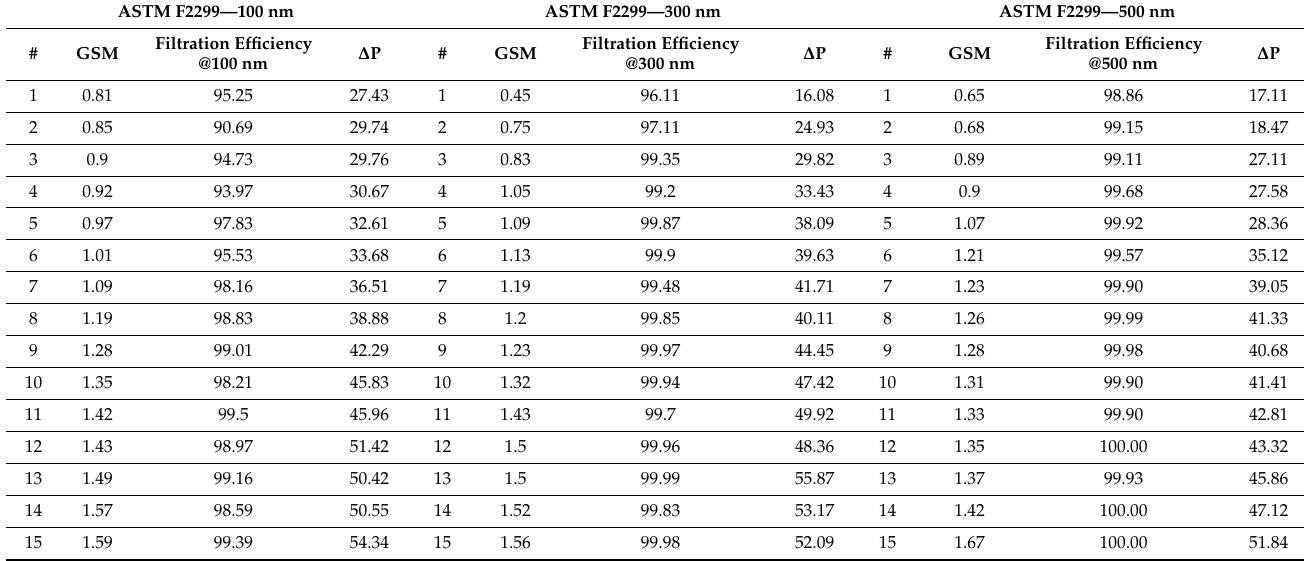
Table 2. Filtration efficiency and pressure drop results across varying aerial weight tested in accordance with ASTM F2299. ASTM F2299—100 nm ASTM F2299—300 nm ASTM F2299—500 nm